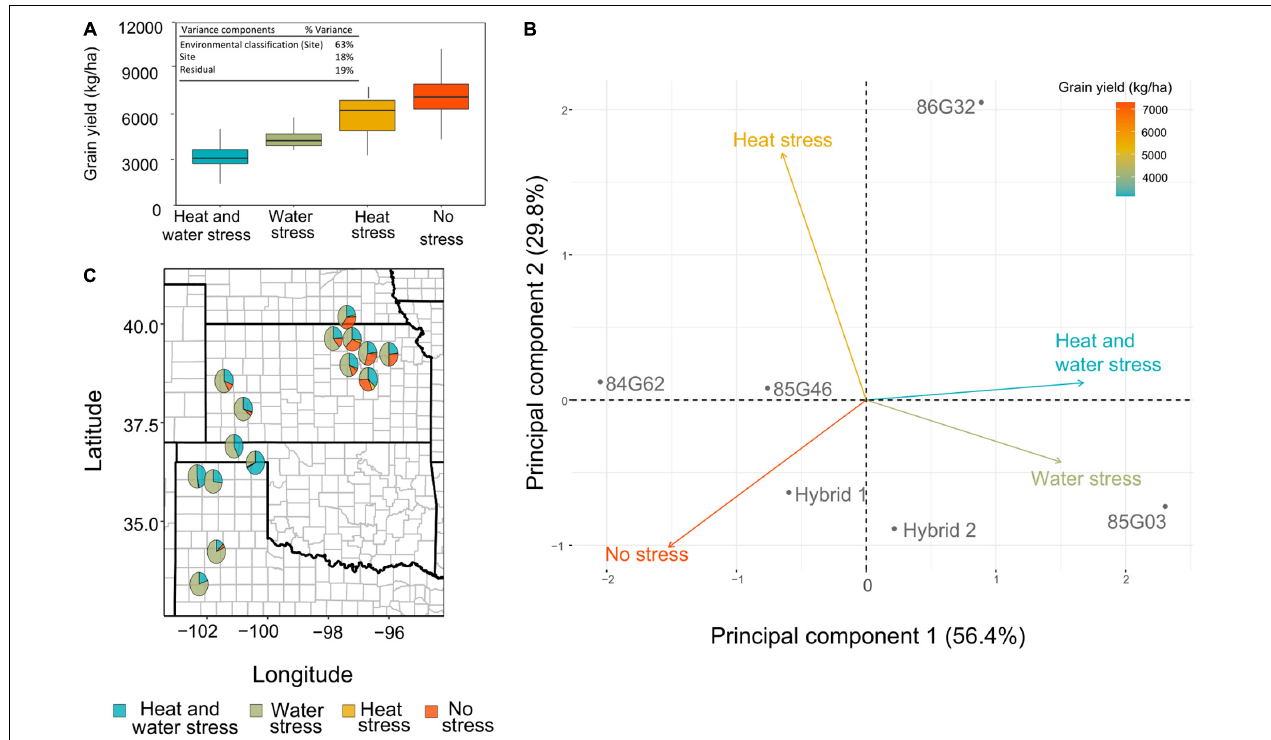
FIGURE 4 | (A) Observed yield distribution for the four environmental classification groups. ( A , inset) Variance components for observed grain yield in field experiments are expressed as percentage of the total variance explained by each effect. (B) Principal component analysis for observed yield. The points represent the six evaluated hybrids and the vector the four environmental categories. (C) United States Great plains map with the environment category group (ECG) frequencies represented as pie charts. The pie charts are placed in the trial sites for the model